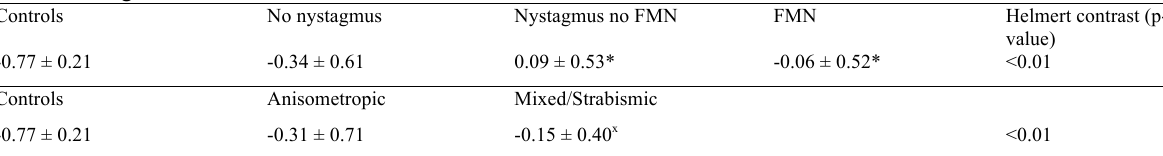
Table 2: Vergence BCEA